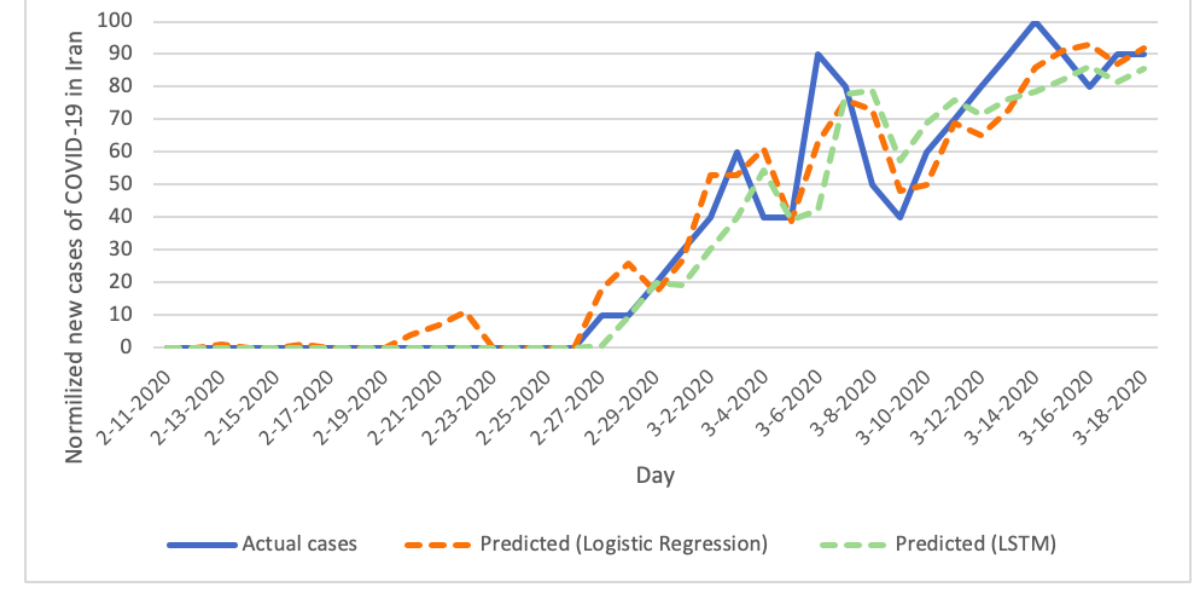
Figure 3. Actual and predicted new cases of COVID-19. LSTM: long short-term memory; COVID-19: coronavirus